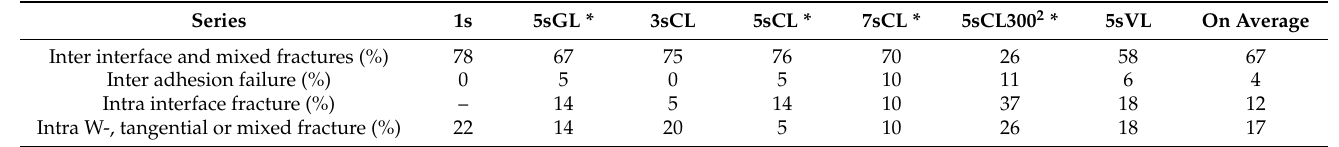
Table 5. Shares of intra and inter